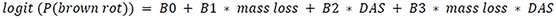
Multi-species isolate survey dilute alkali solubility (DAS) for (A) Birch (Betula papyrifera) and (B) southern pine (eg, Pinus taeda) as a function of mass loss.Contour lines are overlaid representing predicted mass loss-dependent probabilities (90%, 50%, and 10%) of observing brown rot at the corresponding DAS. DAS observations above the lines have a greater probability of being brown rot. Probabilities across the DAS/mass loss variable space were generated using a binary logistic regression model (logit (Pbrown rot) = B0 + B1 * mass loss + B2 * DAS + B3 * mass loss * DAS) developed from experimental values for each substrate independently.